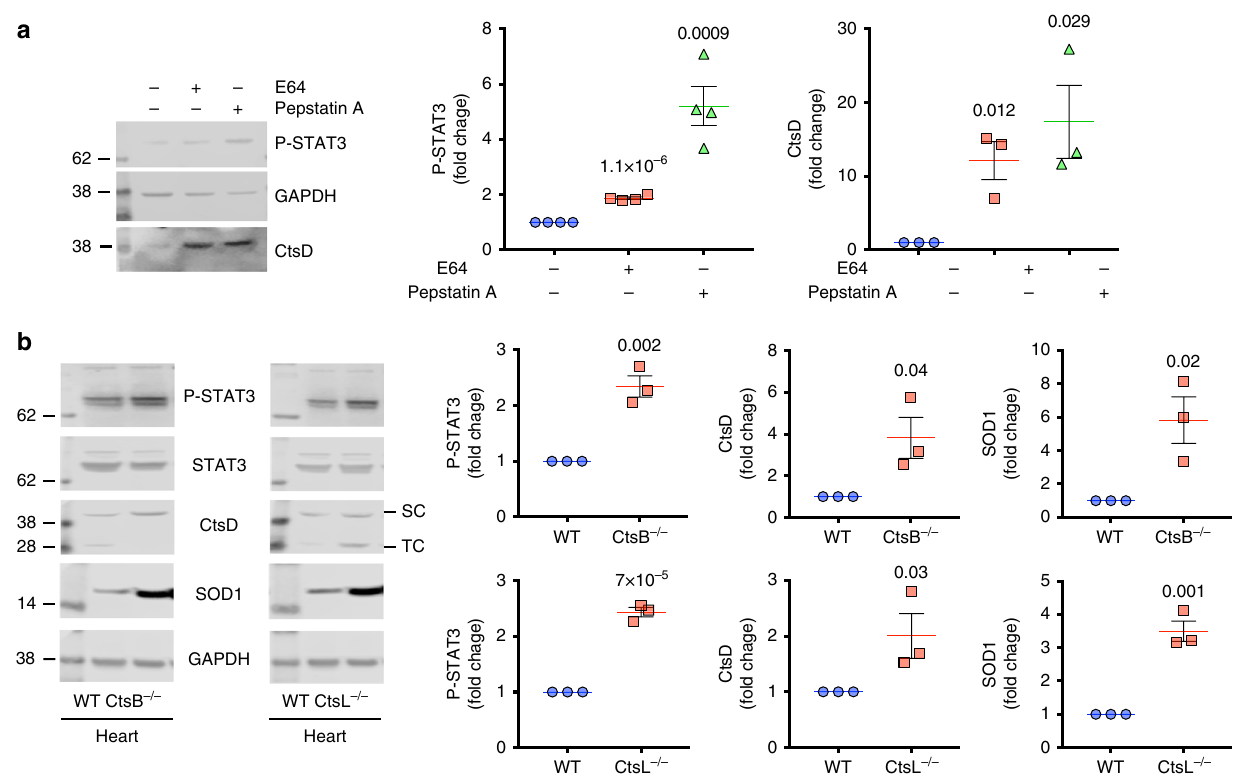
Fig. 9 Chronic or acute inhibition of cysteine or aspartyl cathepsins lead to a similar response. a Levels of P-STAT3 and CtsD in WT MEFs treated or not with 10 μ M E64 or 5 μ M Pepstatin A for 72 h. Data are the average ± SD of n = 4 biologically independent samples for P-STAT3 and n = 3 biologically independent samples for CtsD. Statistical signi fi cance was calculated using a two-sided unpaired t- test. b Levels of P-STAT3, STAT3, CtsD and SOD1 in CtsB − / − heart or CtsL − / − heart compared to WT heart. Data are the average ± SD of n = 3 biologically independent samples. Statistical signi fi cance was calculated using a two-sided unpaired t- STAT3-YFP and TFEB-GFP cellular distribution in HKC-8 cells . The TFEB-GFP construct was purchased from Acris Antibodies. STAT3-YFP was cloned into pcDNA5. HKC-8 cells (5× 10 4 cells/coverslip) were transfected with STAT3-YFP or TFEB-GFP using polyethylenimine (PEI) 62 and 24h later cells were treated as indicated in the fi gure legends. After fi xation with 4% paraformaldehyde in PBS at room temperature for 20min the coverslips were washed three times with PBS 1× and mounted using Vectashield mounting medium containing DAPI (Vector Laboratories) and viewed using an LSM 700 confocal microscope (Carl Zeiss).